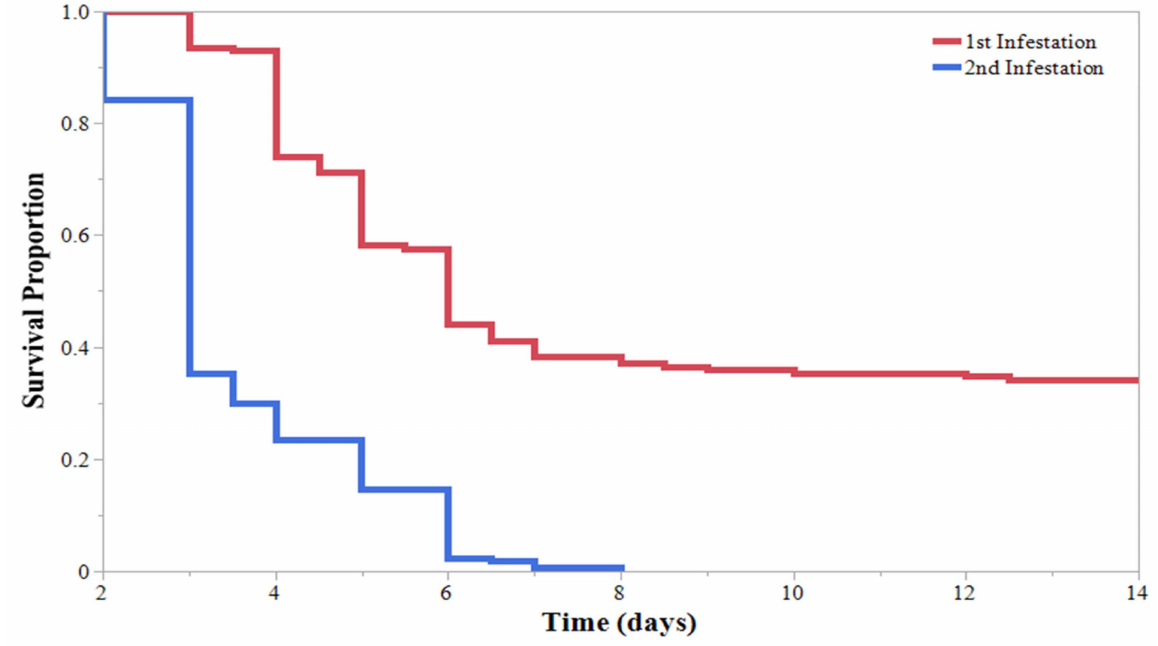
Figure 6. Kaplan–Meier survival curves for Helicoverpa zea (Lepidoptera: Noctuidae) larvae compar- ing survival times of the 1st infestation and the 2nd infestation regardless of initial larval instar. The larvae from the 2nd infestation died significantly faster than larvae from the 1st infestation. Log-rank test: χ 2 = 151.375, p <